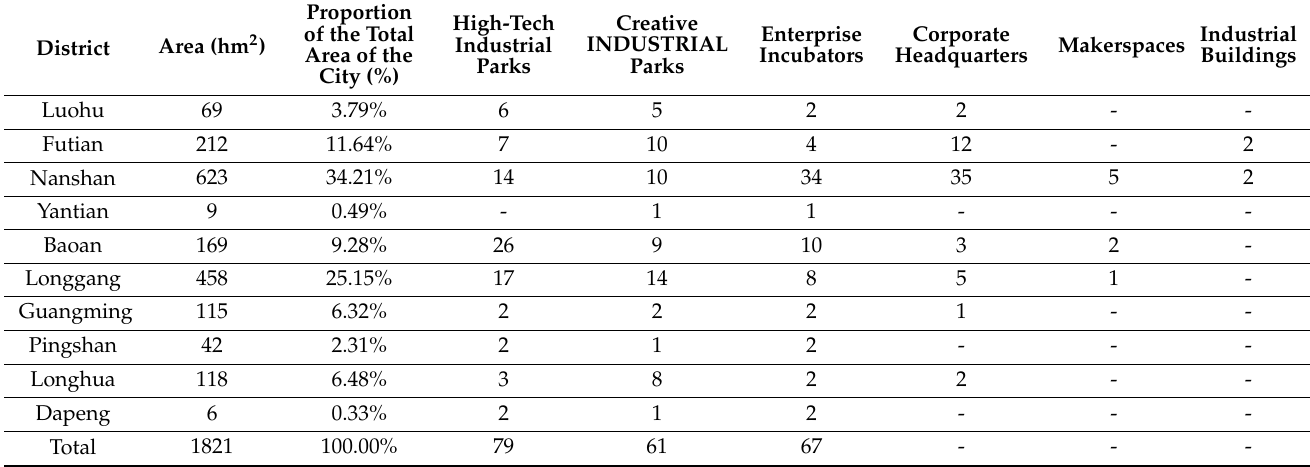
Table 1. Types and distribution of emerging industry land in